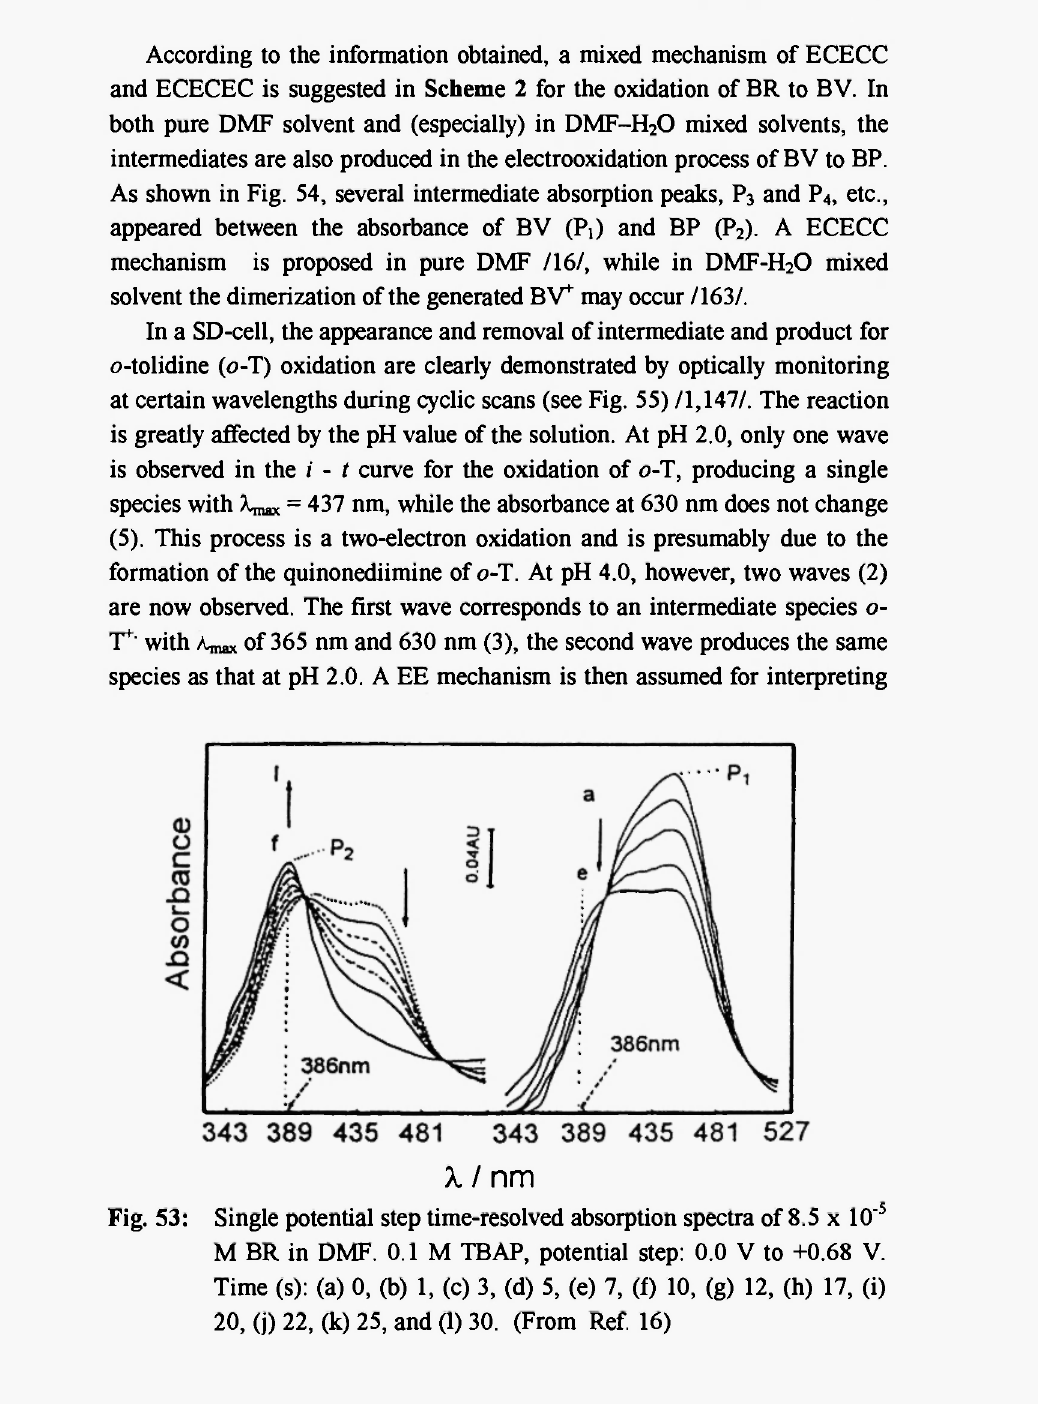
Fig. 53: Single potential step time-resolved absorption spectra of 8.5 χ 10" 5 Μ BR in DMF. 0.1 Μ TB AP, potential step: 0.0 V to +0.68 V. Time (s): (a) 0, (b) 1, (c) 3, (d) 5, (e) 7, (f) 10, (g) 12, (h) 17, (i) 20, (j) 22, (k) 25, and (1) 30. (From Ref. 16)